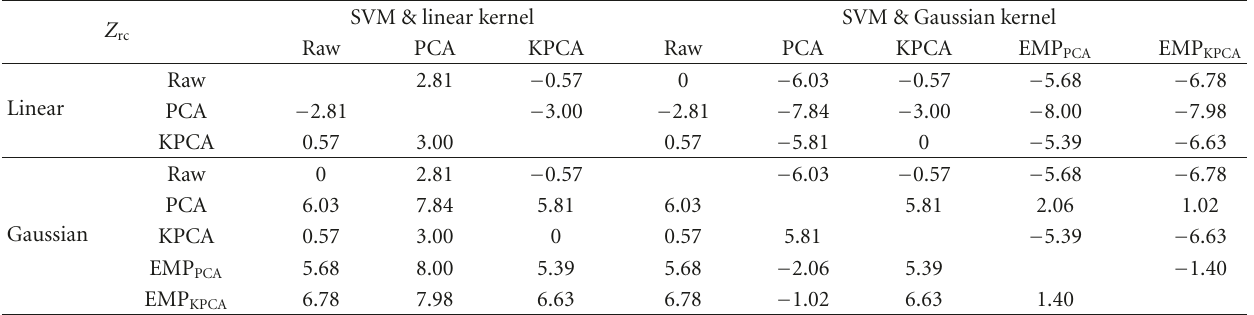
Table 11: Statistical Significance of Di ff erences in Classification ( Z ) for the Washington DC data set. Each case of the table represents Z rc where r is the row and c is the